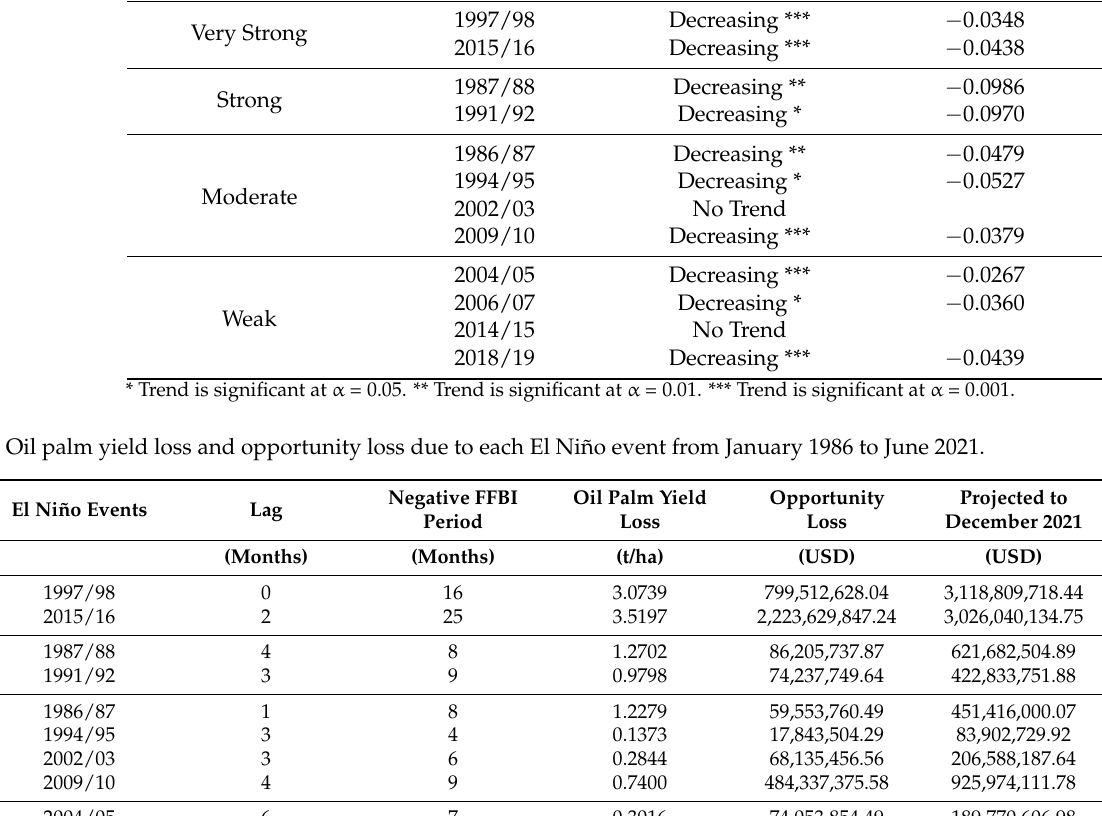
Table 7. Mann Kendall’s trend test and Sen’s Slope Test during each El Niño event from January 1986 to June 2021. Category El Niño Events MK Trend of FFBI Sen’s Slope 1997/98 Decreasing *** − 0.0348 Very Strong 2015/16 Decreasing *** − 0.0438 1987/88 Decreasing ** − 0.0986 Strong 1991/92 Decreasing * − 0.0970 1986/87 Moderate